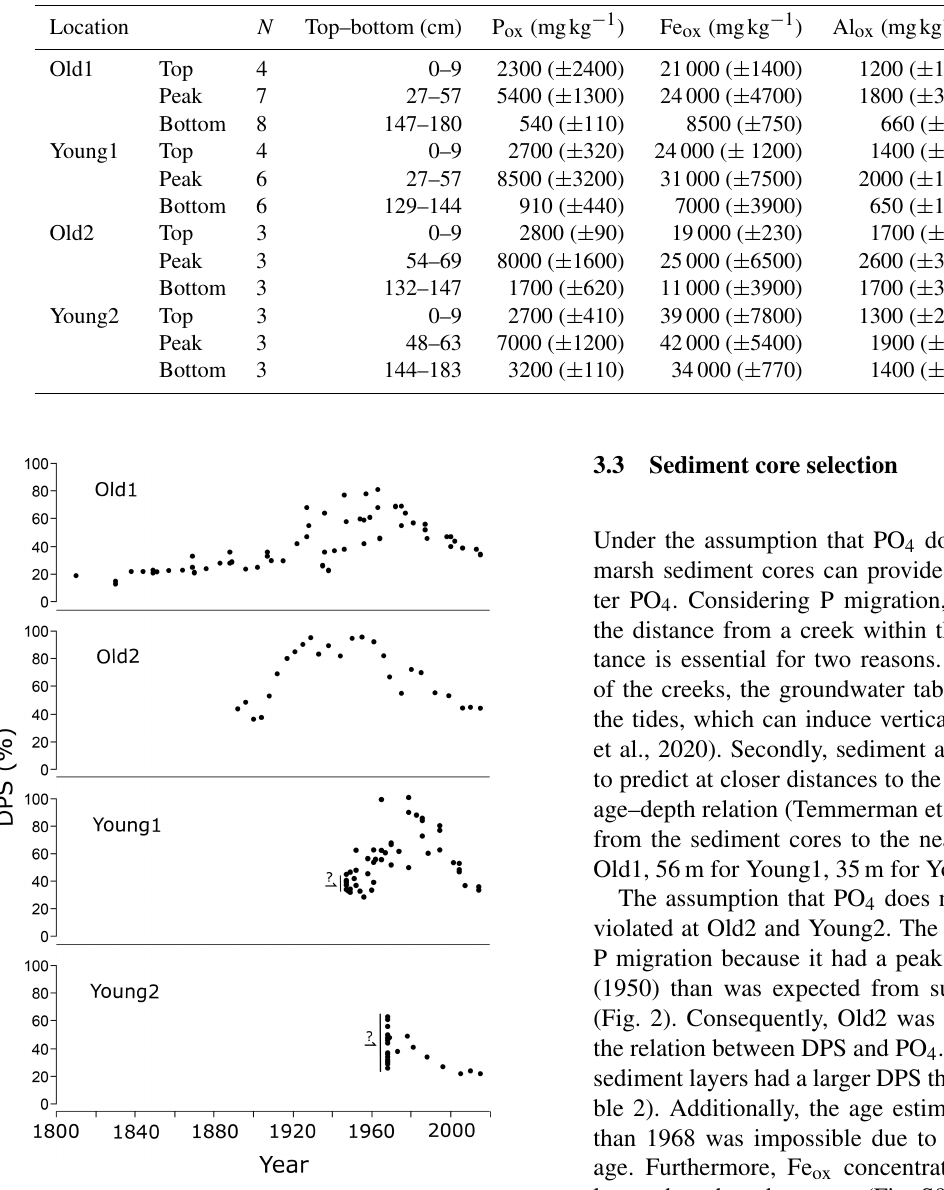
Figure 3. The degree of phosphate saturation (DPS) timeline based on four tidal marsh sediment sites. Each dot represents a sediment analysis. The year assigned to each sediment analysis was calcu- lated with the age–depth model. Before 1930, no model dates were available. Therefore a linear regression of the MHWL was used to extrapolate the dates for the old marshes. Dates before 1930 are in- creasingly uncertain going further back in time. For young marshes, such extrapolation was not possible. The points before the forma- tion of the marshes are indicated with a question